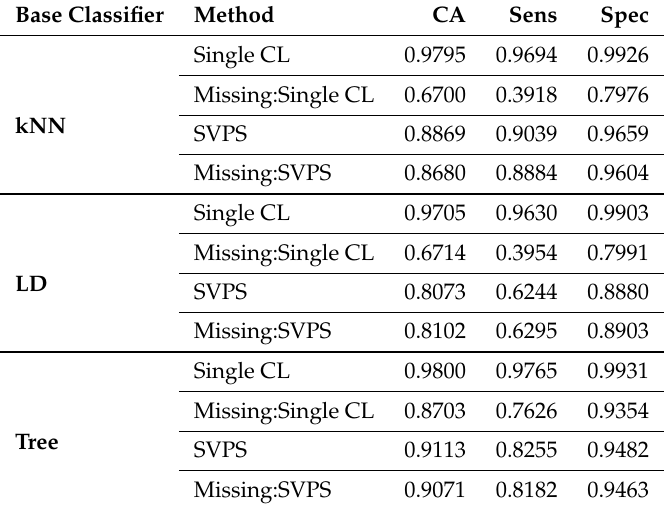
Table 1. Average classification scores for